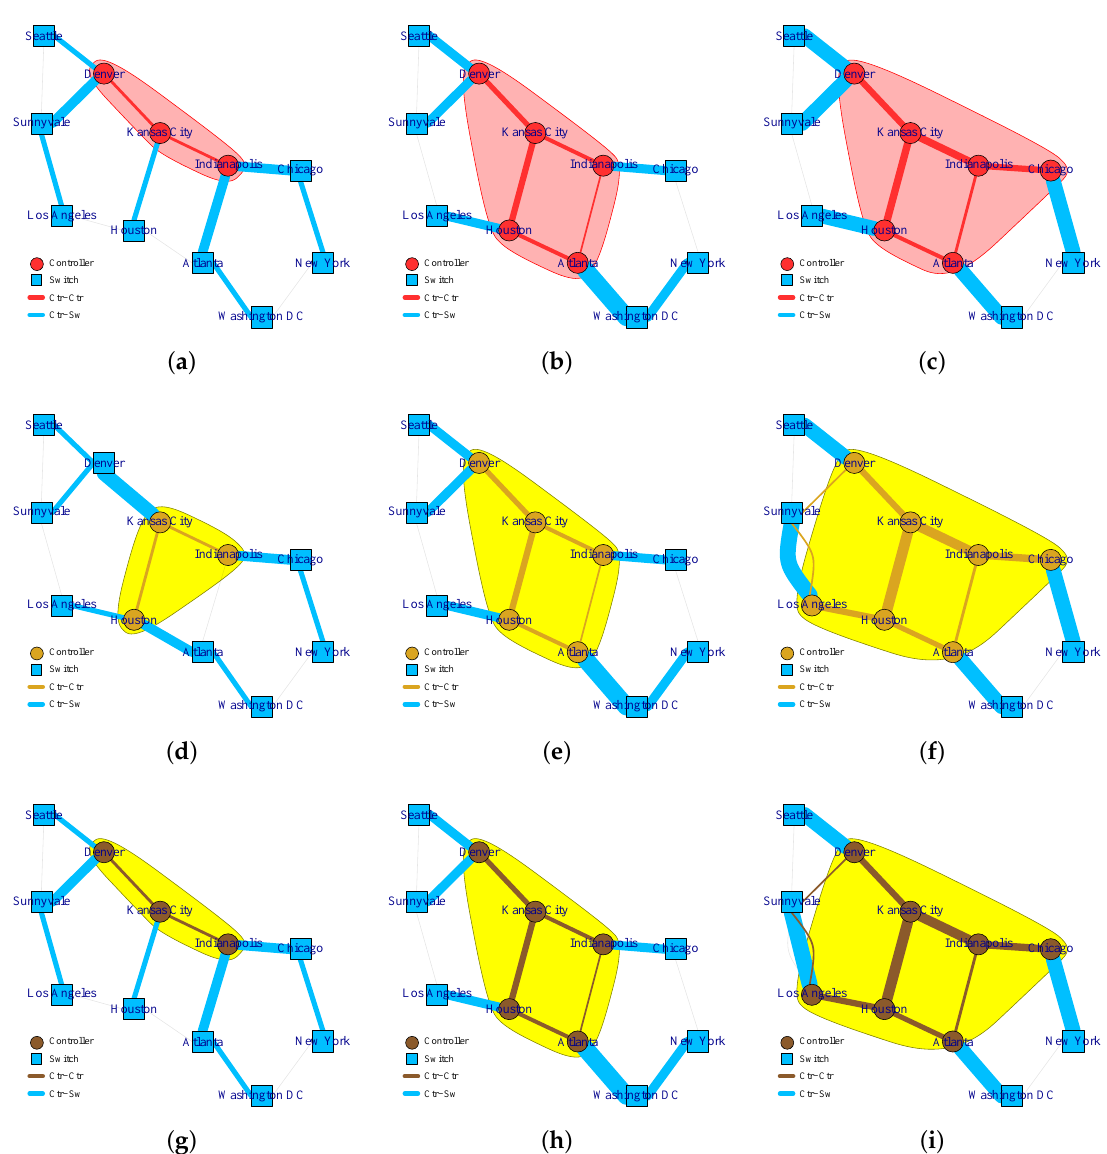
Figure 7. Visualization of the optimal and heuristic controller placements on the “Abilene” network topology for various f β s / β c = 8.21, 15.44 or 24.64. The colour of each edge indicates whether the corresponding link is used for Ctr–Ctr and/or Ctr–Sw traffic, while the edge width indicates the bandwidth used for this traffic. ( a ) Optimal placement ( f β s / β c = 8.21). ( b ) Optimal placement for f β s / β c = 15.44. ( c ) Optimal placement for f β s / β c = 24.64. ( d ) Heuristic placement for f β s / β c = 8.21. ( e ) Heuristic placement for f β s / β c = 15.44. ( f ) Heuristic placement for f β s / β c = 24.64. ( g ) Local-search-variable placement for f β s / β c = 8.21. ( h ) Local-search-variable placement for f β s / β c = 15.44. ( i ) Local-search-variable placement for f β s / β c = 24.64. For f β s / β c = 15.44, all three solutions are identical, as depicted in Figure 7b,e,h. Finally, for f β s / β c = 24.64, the heuristic solutions (Figure 7f,i) return a more extended set of controllers, compared to the optimal solution (Figure 7c). The result is an approximate 2% increase of the total required bandwidth for the control